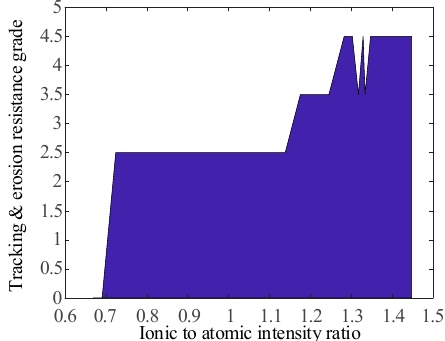
Figure 15. Relationship between the intensity ratio of Mg II 309.7 nm to Mg I 361.3 nm and the tracking and erosion resistance grade.